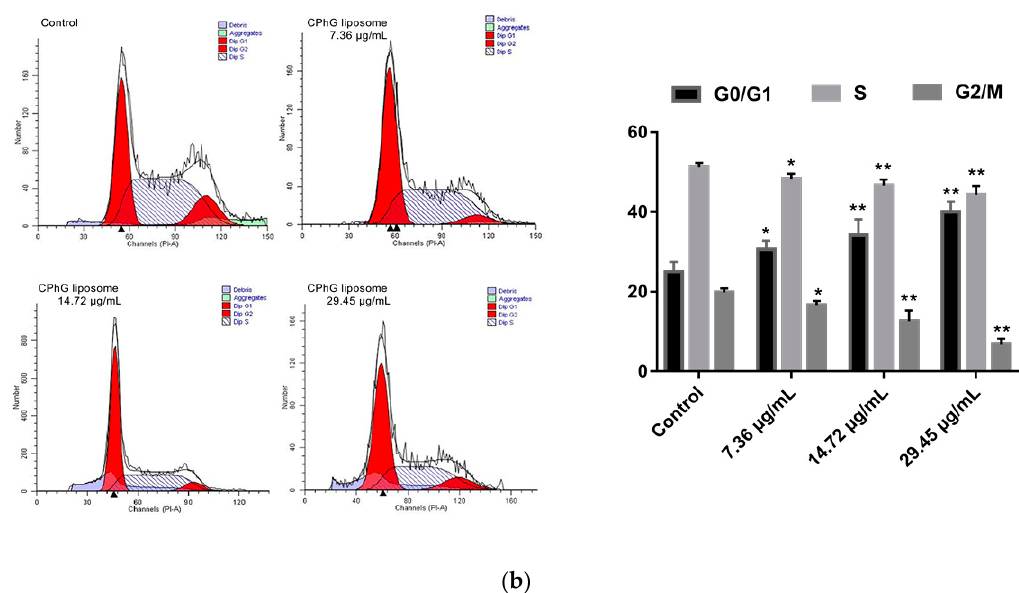
Figure 4. Effect of the CPhG liposomes on the cycle and apoptosis of HSCs. ( a ) Apoptosis of HSCs was analyzed by flow cytometry with AnnexinV-FITC and PE Staining. ( b ) Cell-cycle analysis of HSCs by flow cytometry with PI Staining ( n = 3). Results are the mean ± SD from three independent experiments. * p < 0.05, ** p < 0.01 versus the control values.